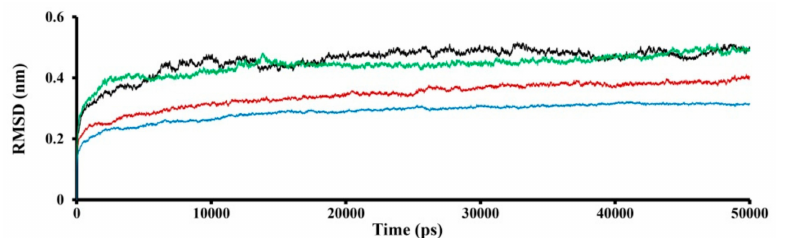
Figure 3. The root–mean–square deviation (RMSD) trajectories of TRPC4 channel alone (in red) and in complex with SWCNTs: SWCNT_1 model is shown in black, SWCNT_2 model in green and SWCNT_3 model in